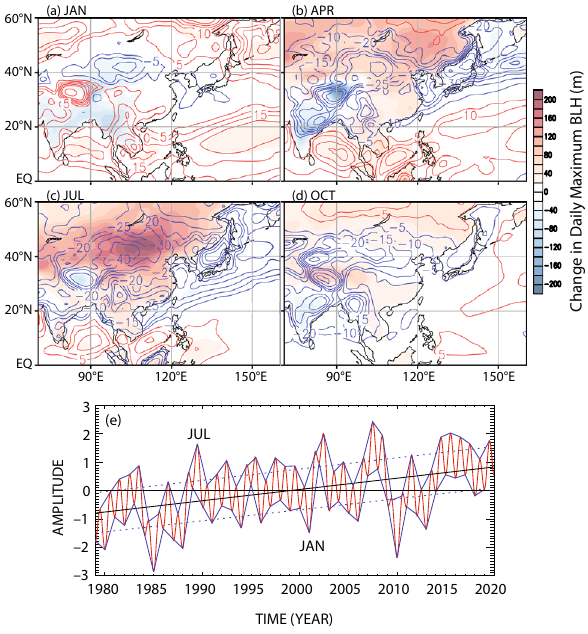
Fig. 8 ( a – d ) The seasonal patterns of daily maximum (shade; m) and daily minimum (contour; m) height of planetary boundary layer for the warming mode. ( e ) The PC time series of the warming mode (red curve) together with the linear trend (black line). Con- tour interval is 5 m (blue < 0 < red). The blue curves represent the PC time series for January and July and the blue dotted lines their respective trends